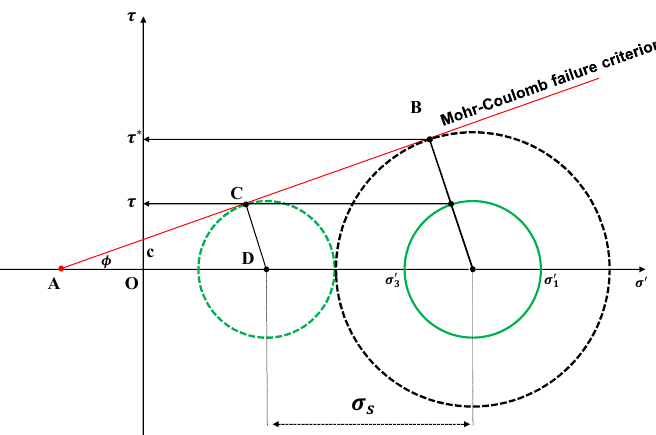
Figure 2. Local factor of safety theory.